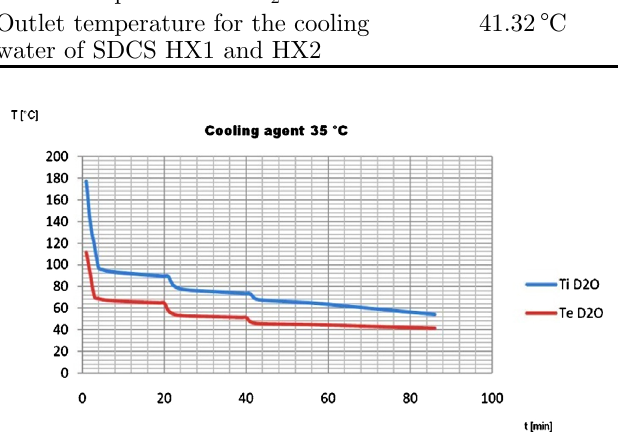
Fig. 3. Examination for 2 HX for cooling agent 35 ° C. Table 6. Thermal analysis. Model V.